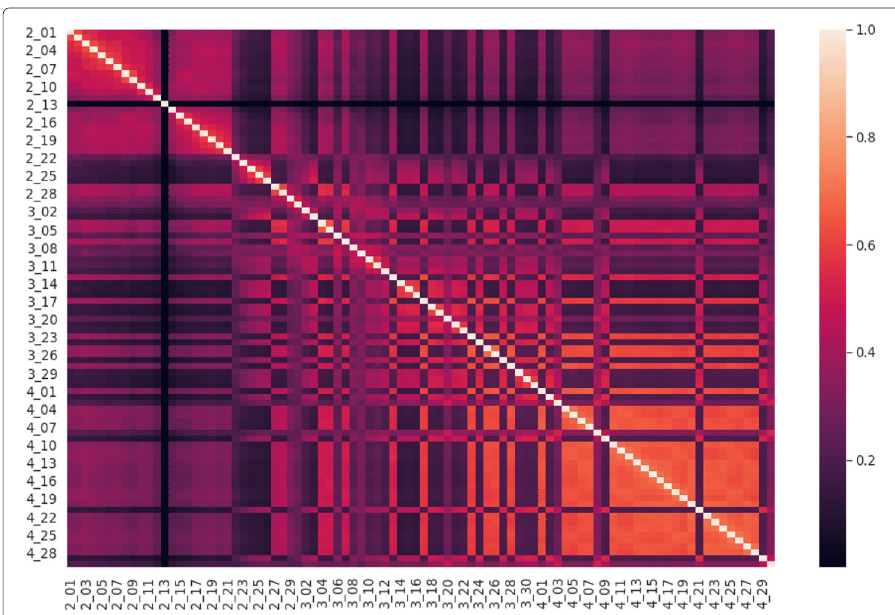
Fig. 5 Heat map of the ARI values between every daily clustering produced by MVMC with every other daily clustering. The heat map shows there are some regions where the consecutive days are more similar to each other than to other days. Examples include early to mid-February in the top left and mid to late-April in the bottom right